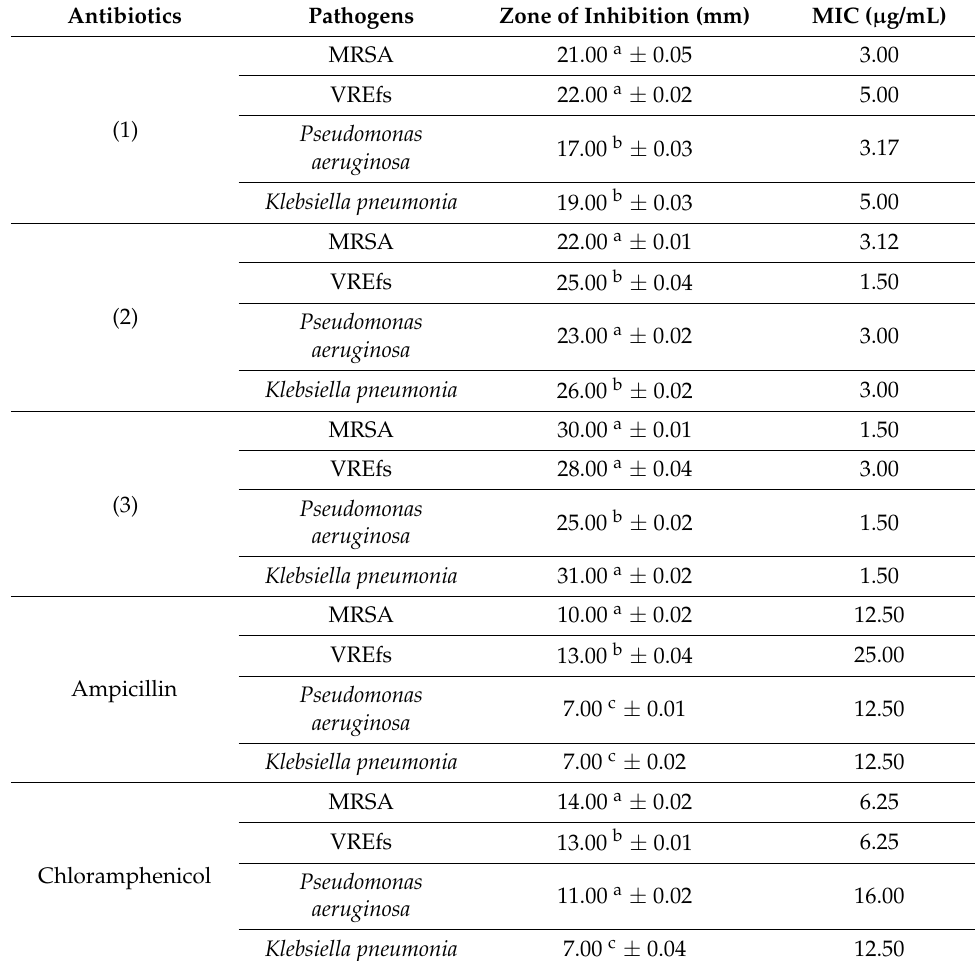
Table 3. Comparison between the bioactivity of bacvalactones (1–3) and standard antibiotics. This table was prepared based on information from Kajal et al. [72]. a–c The column-wise value with superscripts indicates a significant difference ( p < 0.05), which is implied for the statistical analysis of the